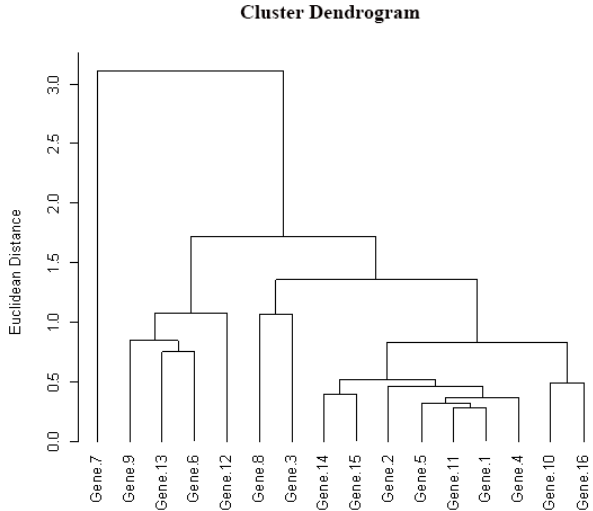
Fig. 4 Fig. 4. Gene Cluster Dendrogram of mussel B. azoricus at 12h post-infection through Euclidean distance, using UPGMA